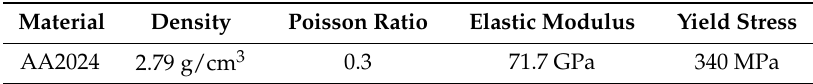
Table 2. Simulation parameters of pressure load mode and displacement load mode.